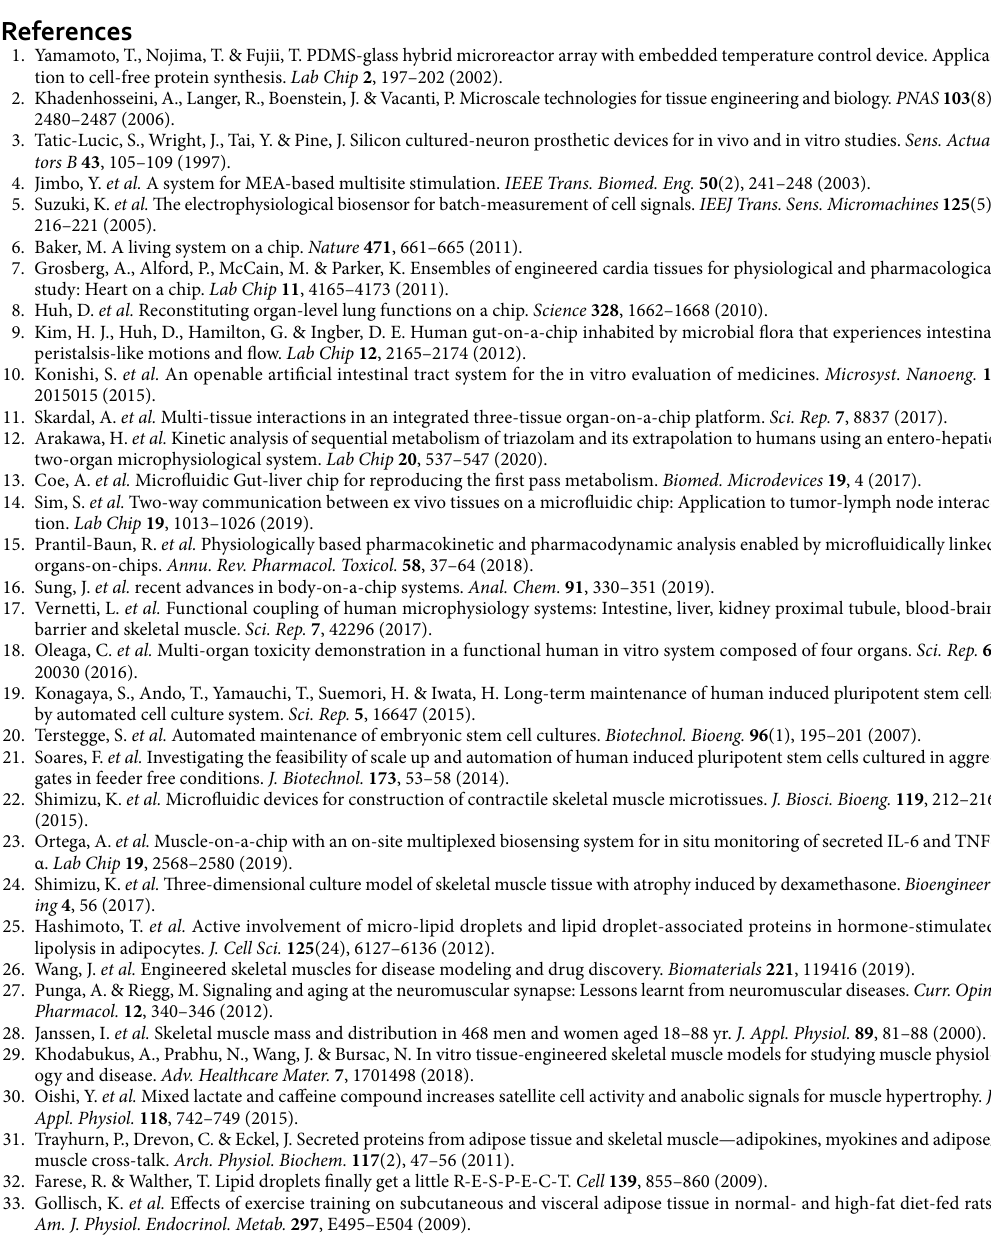
Figure 6. PC-controllable system for feedback control of LDs of adipose cellular tissue. ( a ) A total system composition consisting of subsystems for culture, biochemical stimulation, and imaging. Size change of LDs of adipose cellular tissue was monitored when biochemical stimulation using accelerator and decelerator. ( b ) Flow chart of an algorism for feedback control of LD size by controlling biochemical stimulation. ( c ) Photographs of continual images of adipose tissue and LDs according to time. Typical adipose tissue with LDs was indicated by using a red circle in ( c ). Cluster of LDs distributed and changed its shape and location in a frame. ( d ) The relative change in the LDs content obtained through the image processing by binarizing and thinning according to time (n = 6). The biochemical stimulation was automatically switched when the ratio of LDs changed over a set value as a threshold. The threshold was set at 0.3% of change in the ratio in the experiment. The feedback control of the size of LDs was successfully performed. The biochemical decelerator was automatically supplied when the ratio of LDs increased over a set value as a threshold, whereas accelerator was automatically supplied when LDs decreased over the